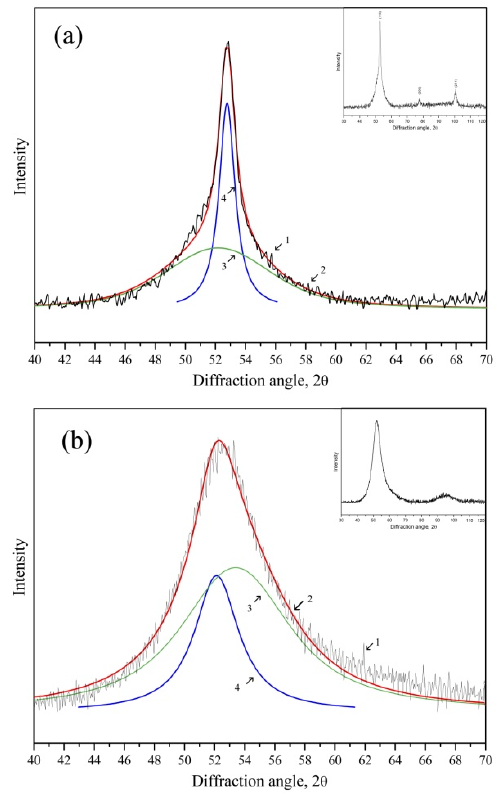
Figure 2. X-ray diffraction patterns of the microwires ( a ) and ribbons ( b ) of Fe 73.8 Si 13 B 9.1 Cu 1 Nb 3.1 composition annealed at 753 K for 1 h (1—experimental curve, 3—scattering from the amorphous phase, 4—diffraction reflections from nanocrystals, 2—summary of curves 3–4).